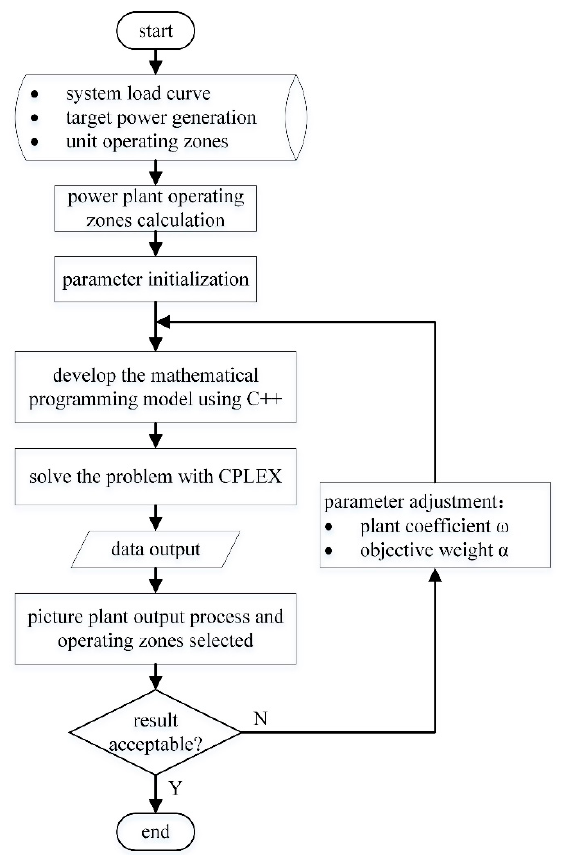
Figure 2. Model development pipeline.